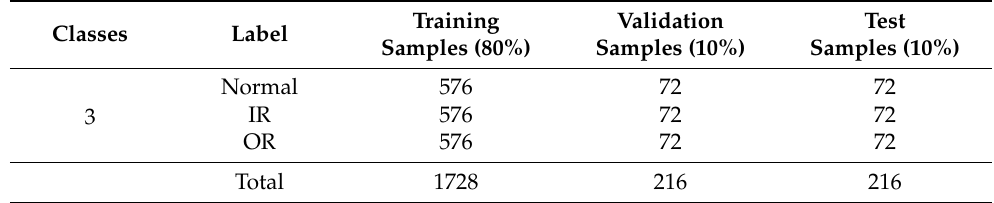
Table 6. Dataset